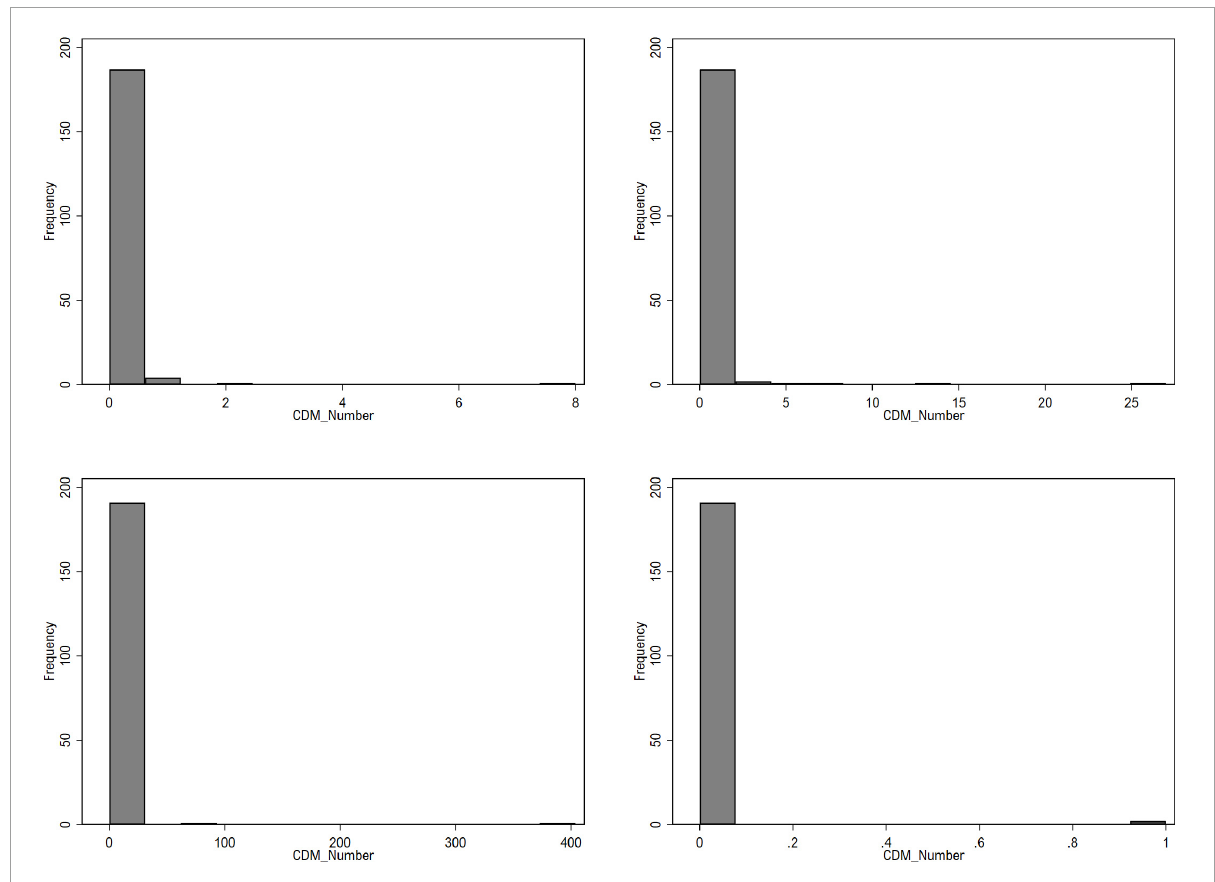
FIGURE3 Histogram of CDM Number by year 2000, 2005, 2010, and 2019 (from top left to bottom right).